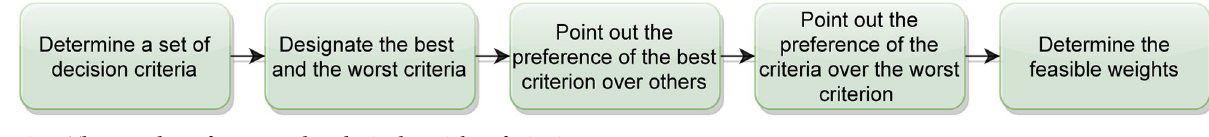
Fig 1. The procedure of BWM used to obtain the weights of